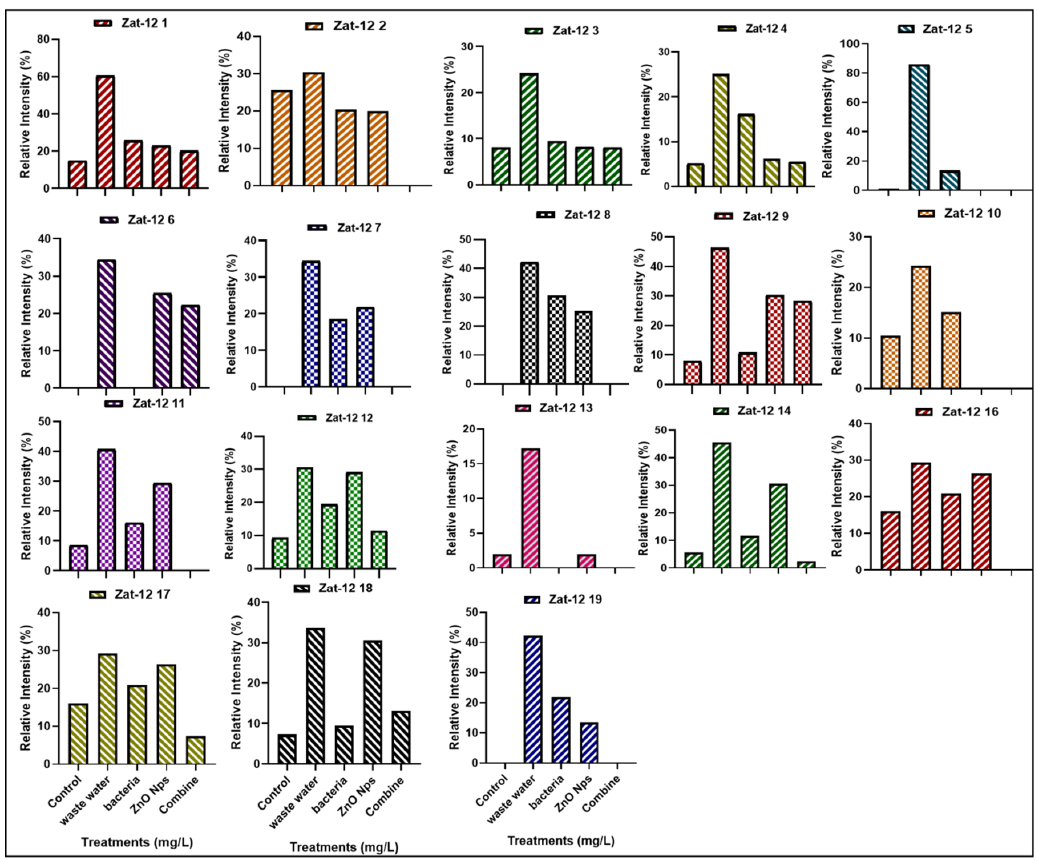
Figure 8. The relative intensity (%) of Zat finger protein (Zat-12) of rice plants that were grown by the synergistic treatment of bacteria-primed seeds that were grown in 5 mg/L ZnO NPs and HMs-contaminated water. The treatments are DW (distilled water), w.w (wastewater), Bio- priming ( Bacillus cereus + w.w), ZnO NPs treatment (5 mg/L + w.w), and combined treatments ( Bacillus cereus + 5 mg/L ZnO NPs +